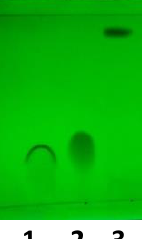
Figure 2. TLC monitoring of the reactions at 300, 450 and 600 Watt in a variation of times (eluent n-hexane- EtOAc 3:2)